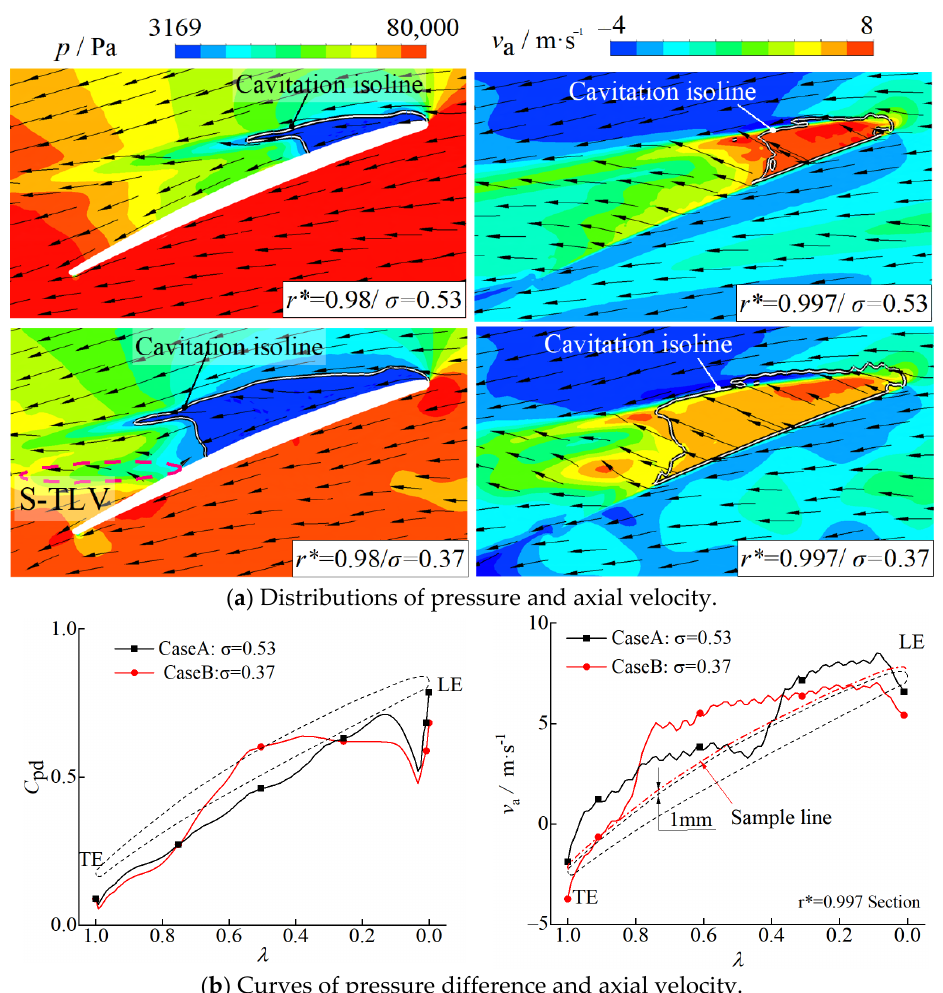
Figure 10. ( a , b ) Distributions of blade pressure difference and axial velocity.